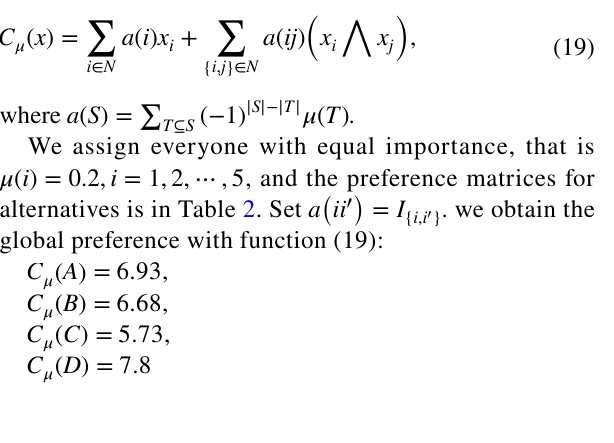
Table 5 The comparison of aggregation mode Aggregation mode Interference term Ranking order Choquet integral a Symmetrical interference Asymmetrical